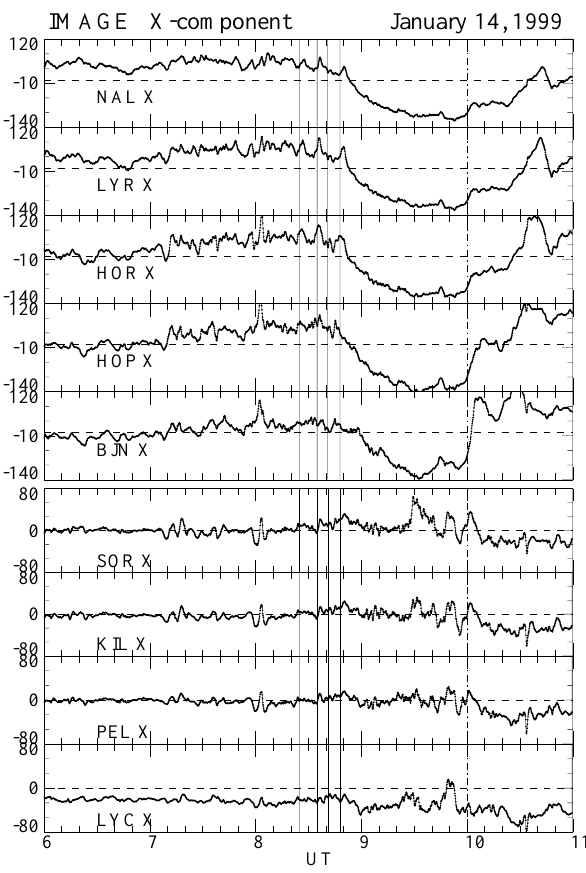
Fig. 15. Magnetometer data from the IMAGE chain of magnetome- ters in Svalbard and Scandinavia. Panels from top to bottom show X-component traces from stations Ny ˚Alesund (NAL; 76.1 ◦